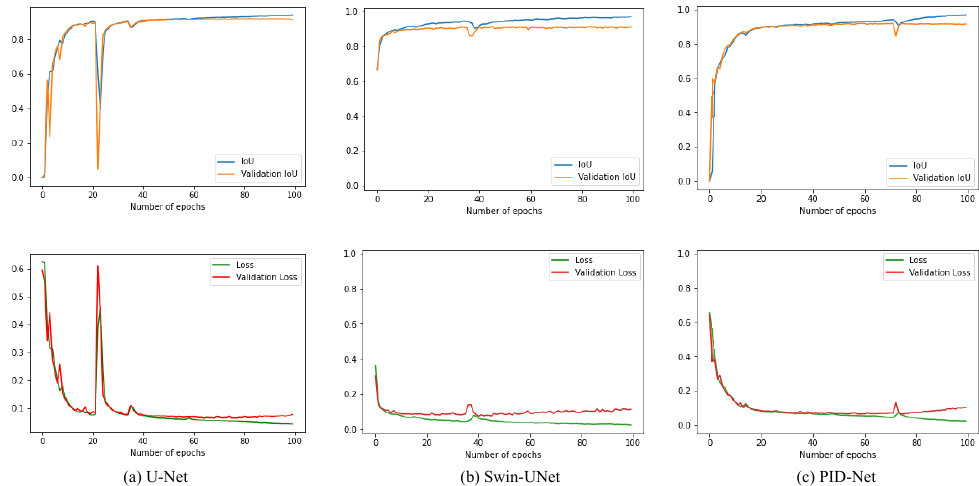
Figure 5. The IoU ( top row ) and loss ( bottom row ) curves in the training